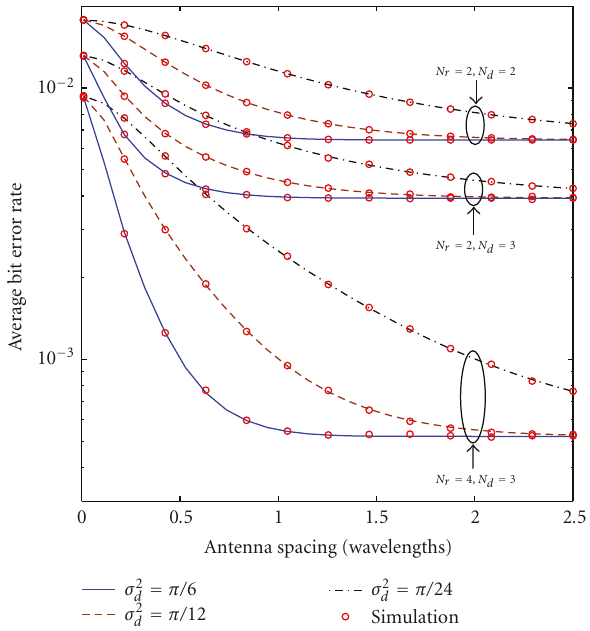
= γ = 10 dB, ρ = 0 . 5, and 1 2